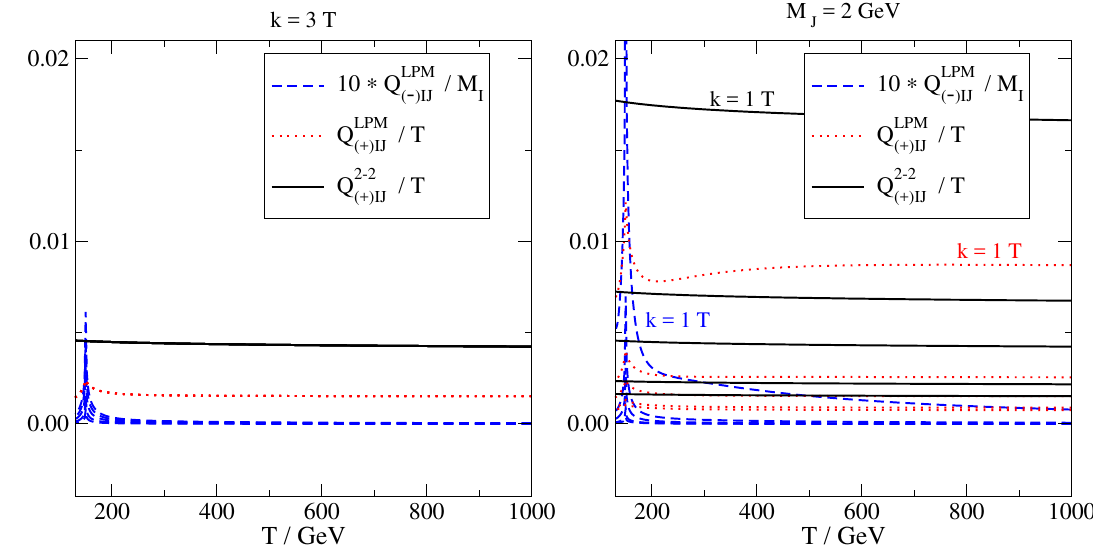
/GeV J is exactly can- I